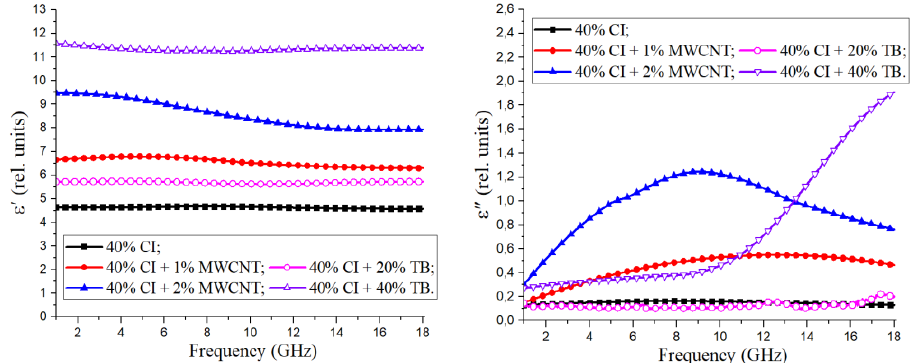
Fig. 4. Frequency dependence of the complex dielectric constant of two-component